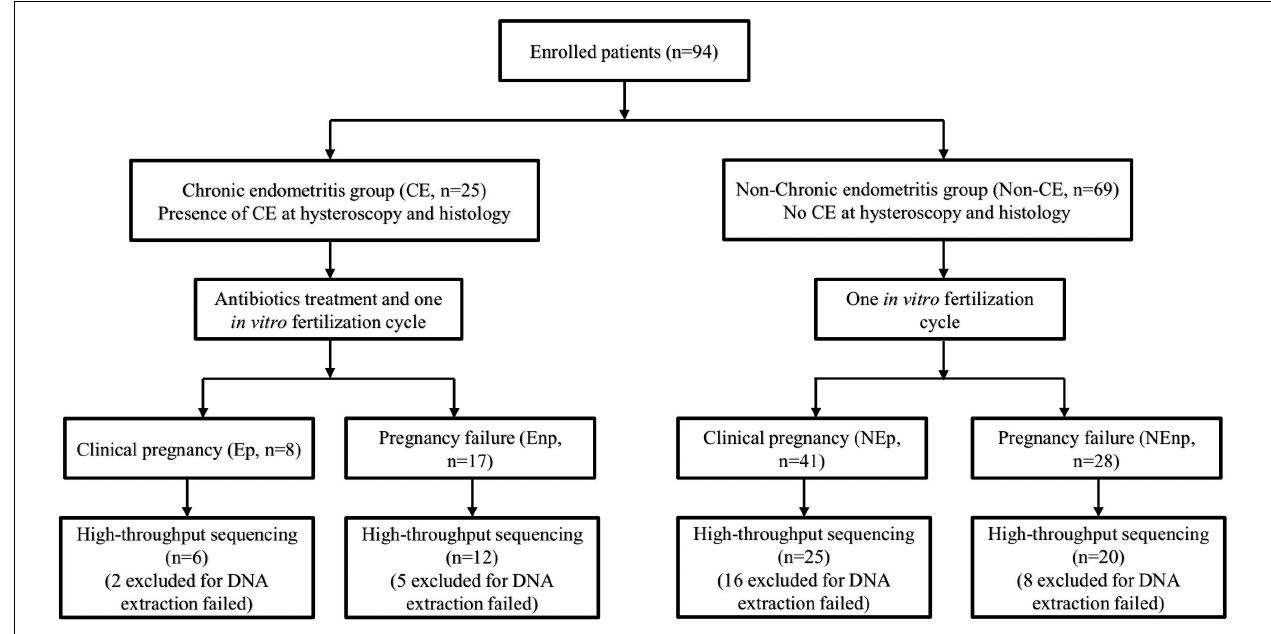
FIGURE 1 | Flow diagram of the trial. IVF, in vitro fertilization.